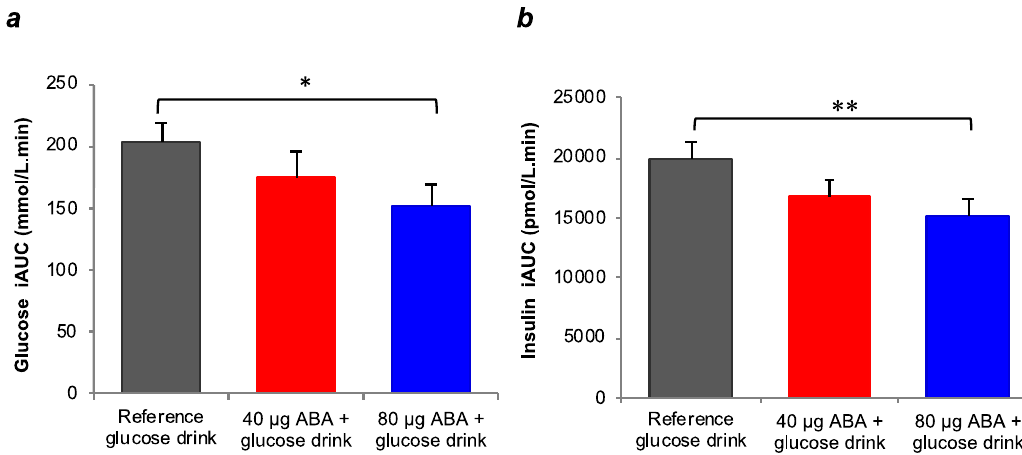
Figure 3. Two-hour incremental area under the curve (iAUC) responses for the two pooled lower 40 µg abscisic acid (ABA) doses (100 mg FFE-50× and 600 mg FFE-10×, n = 20, shown in red) and the two pooled higher doses of ABA (200 mg FFE-50× and 1200 mg FFE-10× n = 20, shown in blue) compared to the reference glucose drink ( n = 30). ( a ) Postprandial glucose responses and ( b ) postprandial insulin responses. Data are shown as mean ± standard error mean (SEM). * indicates a significant difference between pooled higher ABA dose compared to the reference glucose drink at P = 0.042. ** indicates a significant difference between pooled higher ABA dose compared to the reference glucose drink at P = 0.021.